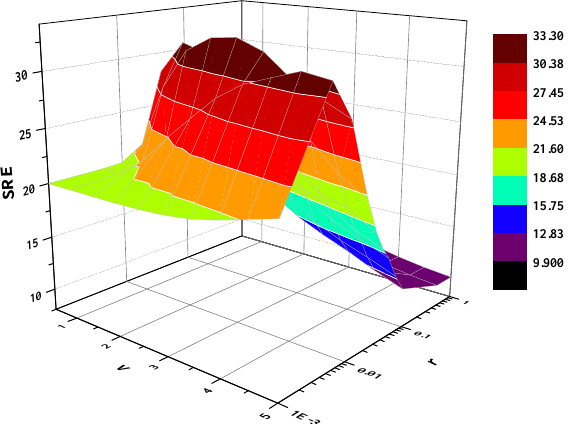
Figure 11. Signal-to-Reconstruction Error (SRE) (dB) values of RGSU with different combinations of inner parameters v and r .